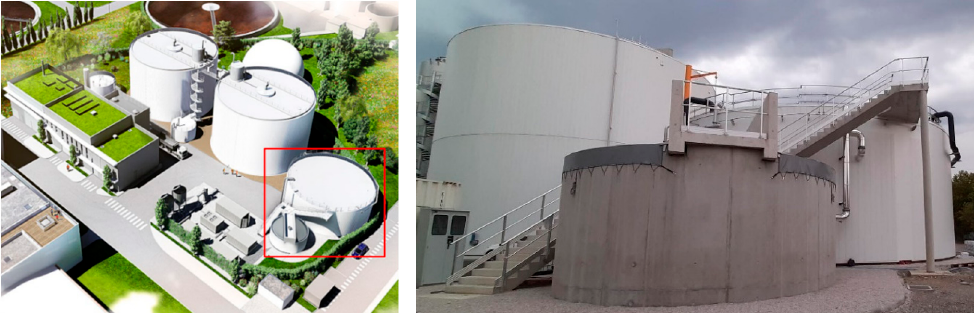
Figure 13. Three-dimensional (3D) drawing of the THP + AD sludge treatment extension project in Toulouse and photo of the IFAS ANITA Mox unit.